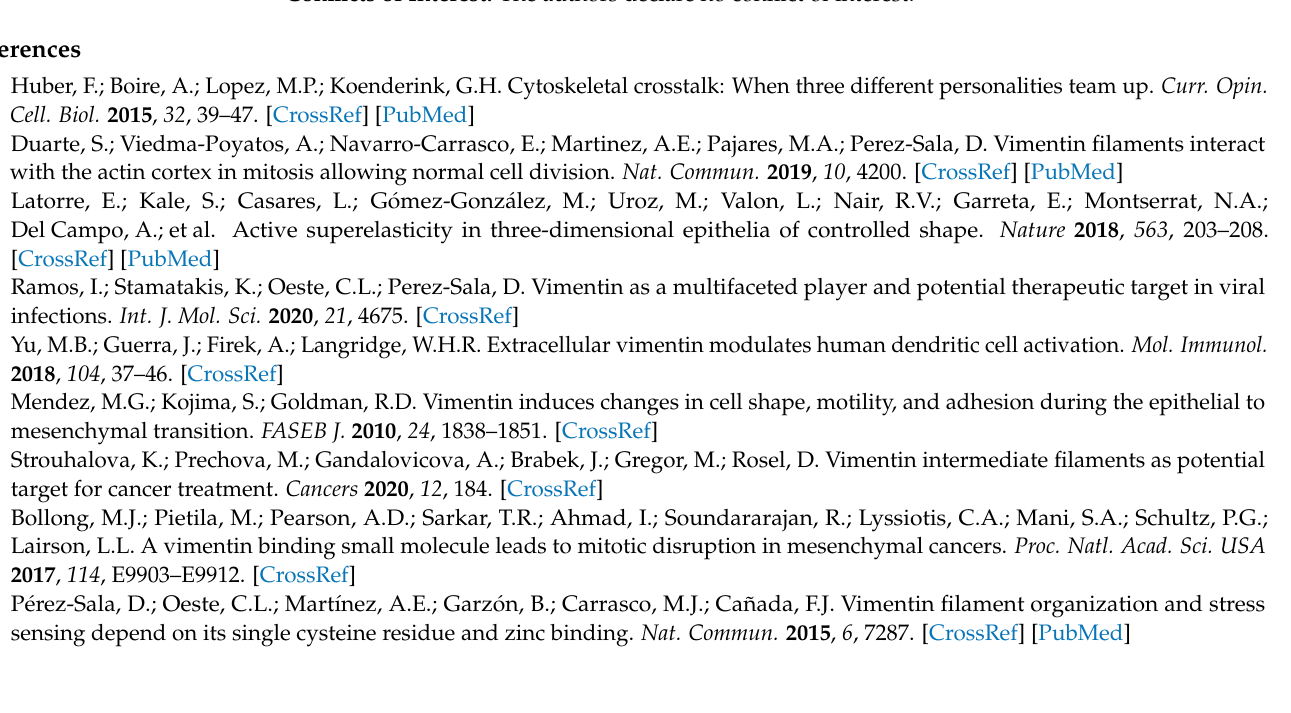
Supplementary Materials: The following are available online at https://www.mdpi.com/article/ 10.3390/antiox10071039/s1, Figure S1: MD simulations of vimentin dimer A (100 ns) and vimentin dimer B (200 ns). RMSD plots, Figure S2: MD simulation of vimentin dimer B with Zinc ions (30 ns). RMSD plot, Figure S3: MD simulation of vimentin dimer B with Cys328 thiol group as thiolate and in presence of Zinc ions (50 ns). RMSD plot, Figure S4: Determination of Cys328 pKa through various methods, Figure S5: Competition assay between vimentin and Zincon for zinc binding, Figure S6: MD simulation of vimentin dimer Cys328Ser mutant (50 ns). RMSD plot, Figure S7: MD simulations of vimentin tetrameric complexes (100 ns). (A) “distant-CYS” (Cys residues at a distance of 22 Å). (B) “nearby-CYS” (Cys residues at a distance of 4 Å). RMSD plots, Figure S8: MD simulation of vimentin tetrameric “nearby-CYS” complex with Zinc ions (100 ns). RMSD plot, Figure S9: MD simulation of vimentin tetrameric Cys328Ser mutant complex (100 ns). RMSD plot, Figure S10: Protective effect of zinc on Cys328 modification and crosslinking in soluble and polymerized vimentin, Figure S11: Cysteine crosslinkers used in this study, Figure S12: MD simulation of vimentin dimer B with Magnesium ions (100 ns). RMSD plot, Figure S13: Effect of millimolar magnesium concentration on the crosslinking of vimentin by